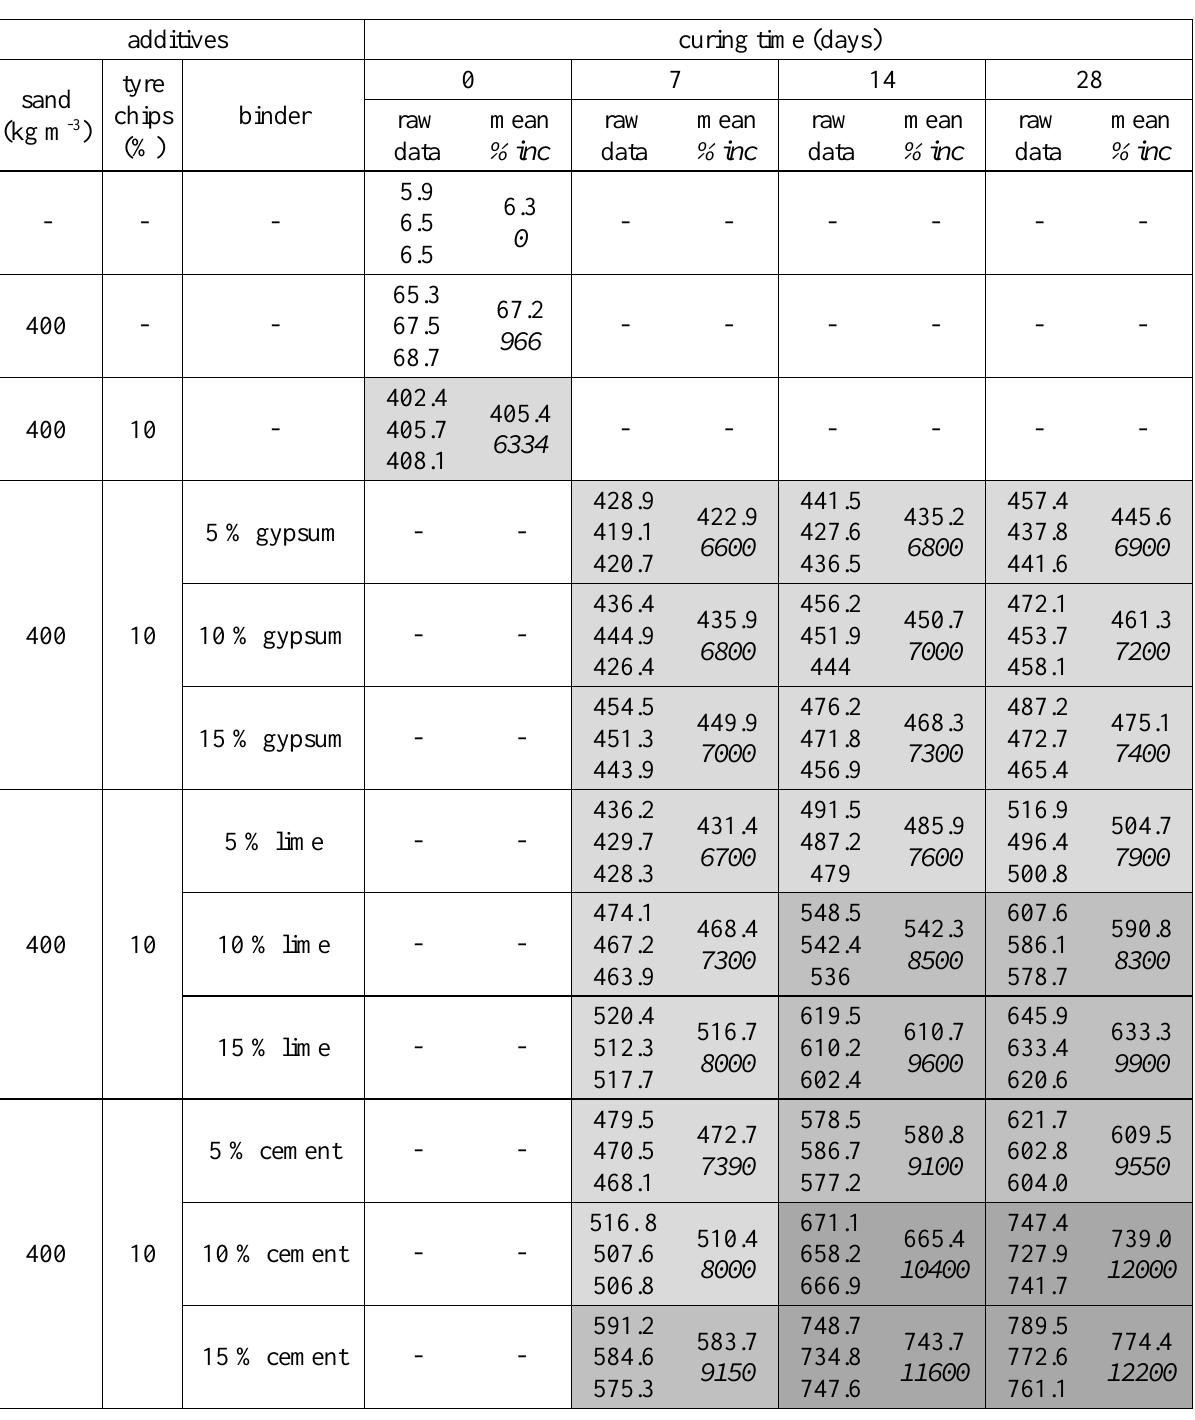
Table A1. Unconfined compressive strength (UCS) of Chaghakhor peat with different combinations of additives and curing times. For each combination, the test results for the three replicate specimens (raw data) are shown on the left, and the mean UCS value on the right. Beneath each mean value, the figure in italics ( %inc ) is the percentage increase in UCS compared with untreated peat (top row). The data for specimens without supplements (top three rows) are taken from Rahgozar & Saberian (2016). The results of all 81 of the UCS tests carried out during this study are shown in the bottom nine rows of the Table. Shading indicates the improvement in UCS achieved: no shading indicates an improvement of ≤ 6000 %; lightest shading >